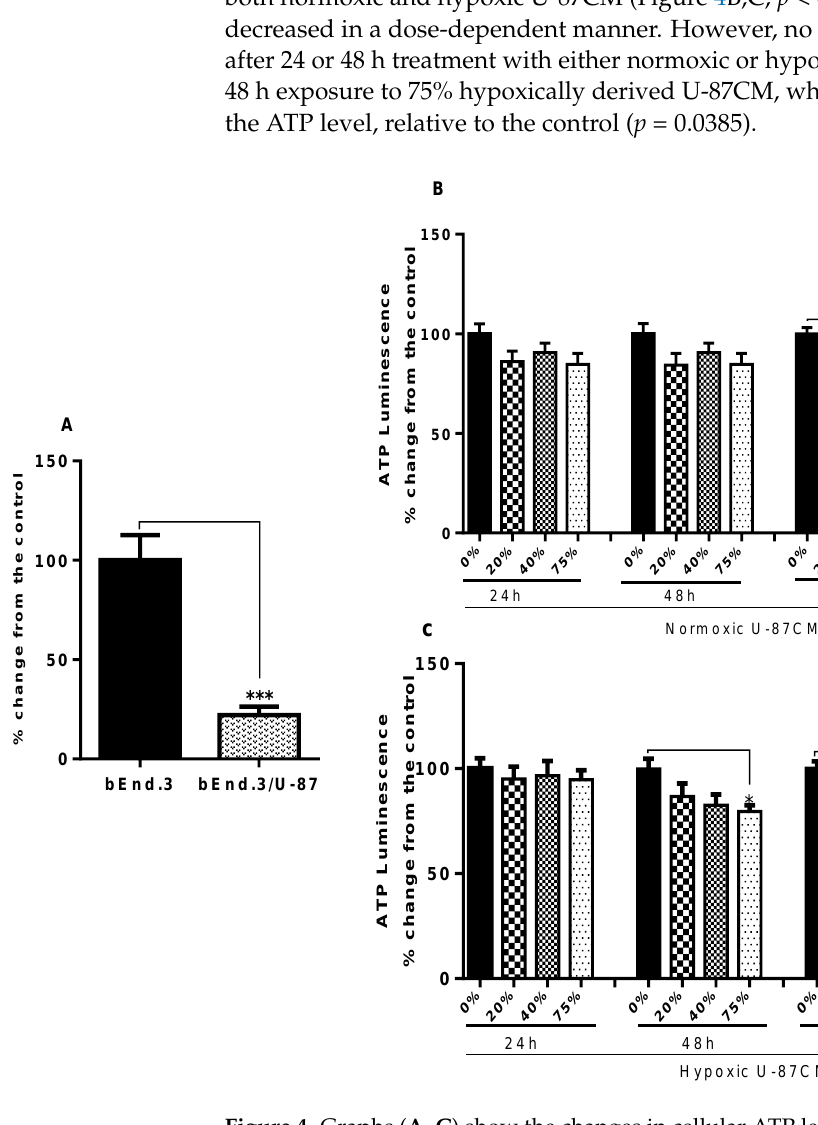
Figure 4. Graphs ( A – C ) show the changes in cellular ATP levels in bEnd.3 cells under the influence of glioblastoma U-87 cells. ( A ) Shows the significant reduction in cellular ATP level in bEnd.3 cells cocultured with glioblastoma U-87 cells, compared to monocultured bEnd.3 cells (*** p = 0.0004), ( n = 4). ( B ) Shows significant reduction in cellular ATP levels in a dose–response manner, compared to the control, after 72 and 96 h in culture in normoxic U-87CM (derived from U-87 cells cultivated in normoxic conditions (21% O 2 ) (**** p < 0.0001)), ( n = 4). ( C ) Shows significant reduction in cellular ATP levels in a dose–response manner, compared to the control, after 72 and 96 h after treatment with selected concentrations of hypoxic U-87CM (derived from U-87 cells cultivated in hypoxic conditions (5% O 2 ) (* p = 0.0385; **** p < 0.0001), ( n =